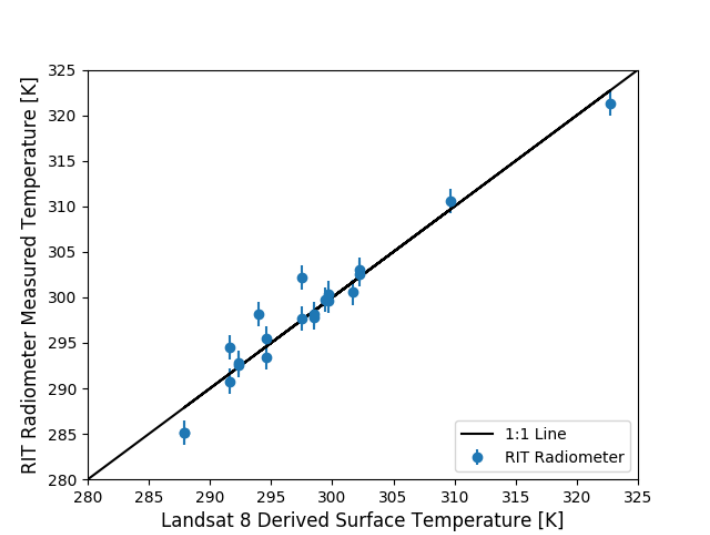
Figure 8. Radiometer-measured vs. Landsat-derived surface temperatures for preliminary field collects. The solid line compares the data to a 1:1 line, a metric similar to the one used by the Landsat calibration validation team